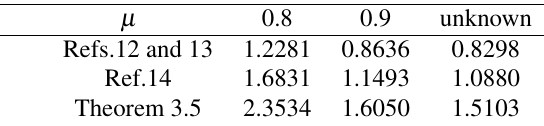
Table 1. delay bounds for different µ